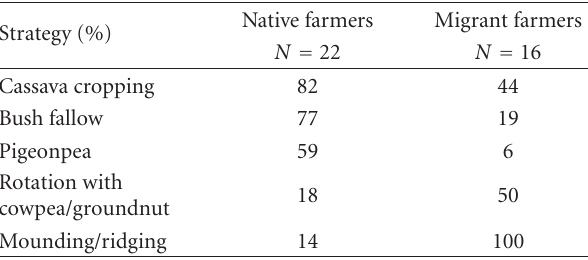
Table 2: Percentage of native and migrant farmers at Asuoano in 2002 practising various soil fertility management